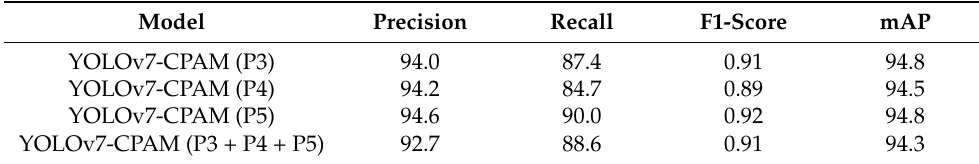
Table 4. The results of CPAM with different embedding positions.